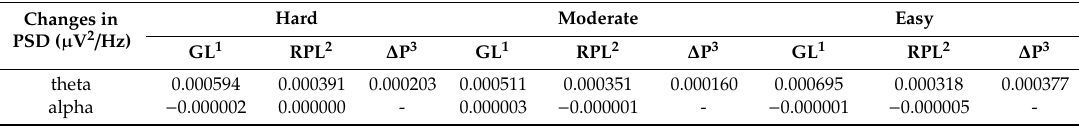
Table 3. Changes in PSD of theta and alpha averaged for all